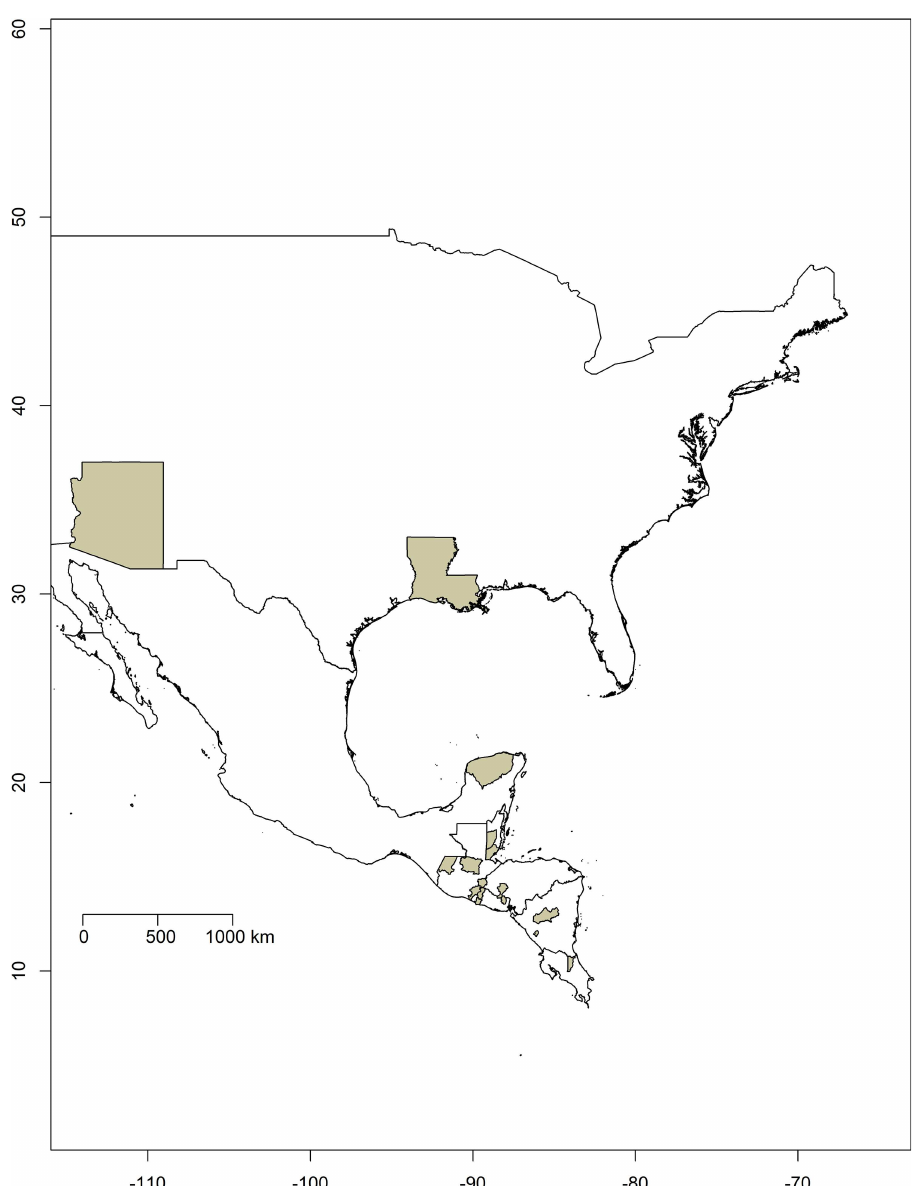
Fig 1. Geographic distribution of field-collected triatomines sampled across North America (United States and Mexico) and Central America. Sampled states in each country are shown in grey. Detailed information is in S1 Table. Base layer for each country and state/department were downloaded from the GADM database of Global Administrative Areas, version 3.6 (https://gadm.org/download_country.html) and maps were plotted using the R package mapdata